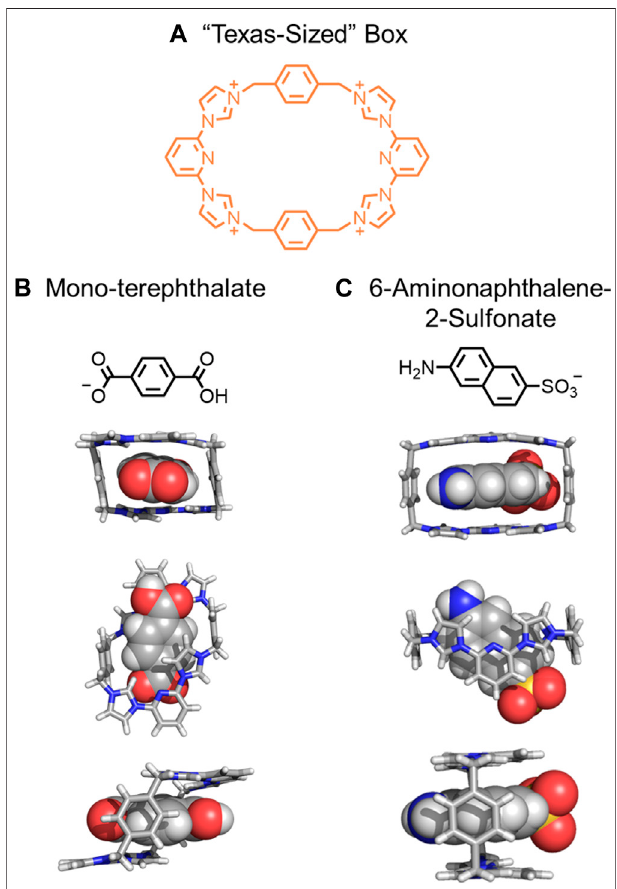
FIGURE 9 | (A) The “ Texas-sized ” box, (B) mono-terephthalate guest and resulting chair conformation, and (C) 6-aminophthalene-2-sulfonate guest and resulting box-like